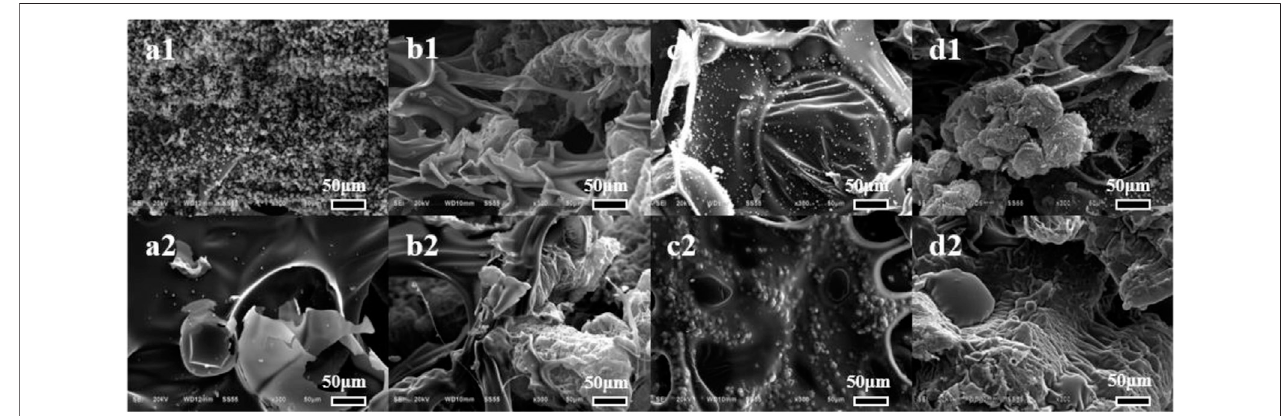
FIGURE 6 | SEM images of the external and internal char residues of RPUF and FR-RPUF composites: (A) RPUF; (B) RPUF/EG30; (C) RPUF/ADP30; (D) RPUF/ ADP15/EG15.